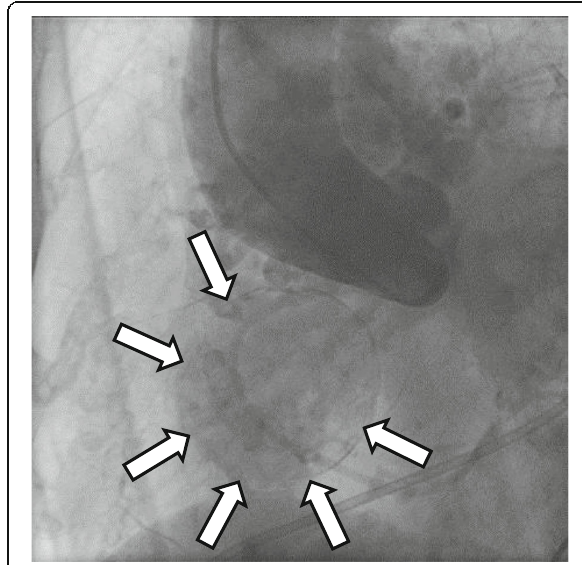
Fig. 2 Coronary angiography. Coronary angiography reveals three coronary artery aneurysms with coronary arteriovenous fistulae. One of the aneurysms from the right coronary artery was a giant coronary artery aneurysm (arrow) with a diameter of 55